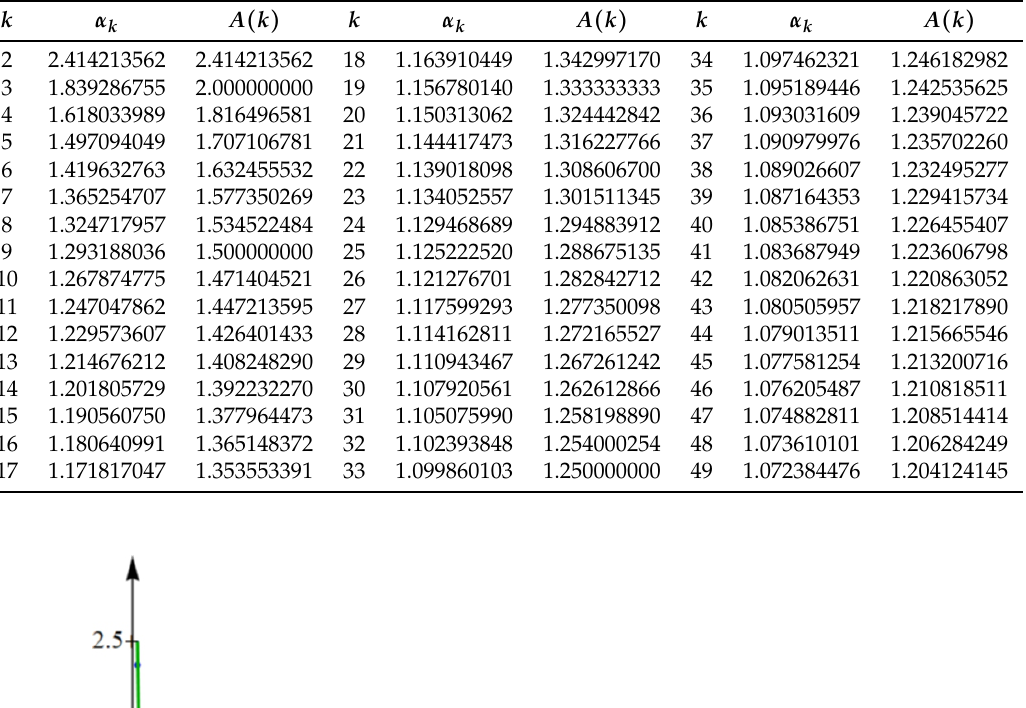
Table 1. The dominant root α k of f k ( x ) = x k − x k − 1 − x − 1 and its upper bound A ( k ) =